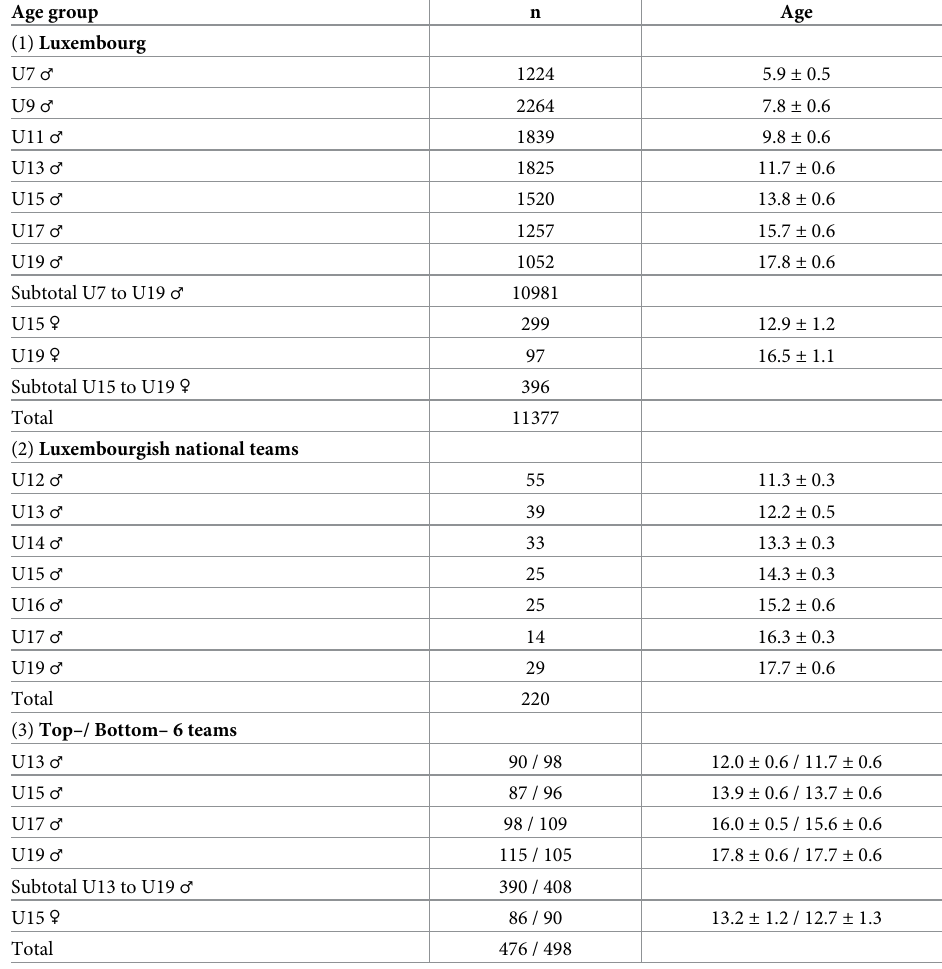
Table 1. Overview of the female and male football players and the age categories in Luxembourgish youth